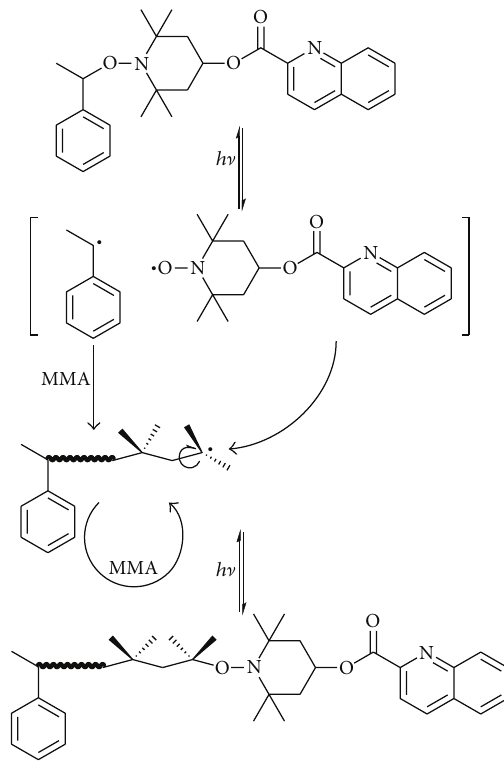
Scheme 2: Polymerization mechanism of MMA in the presence of